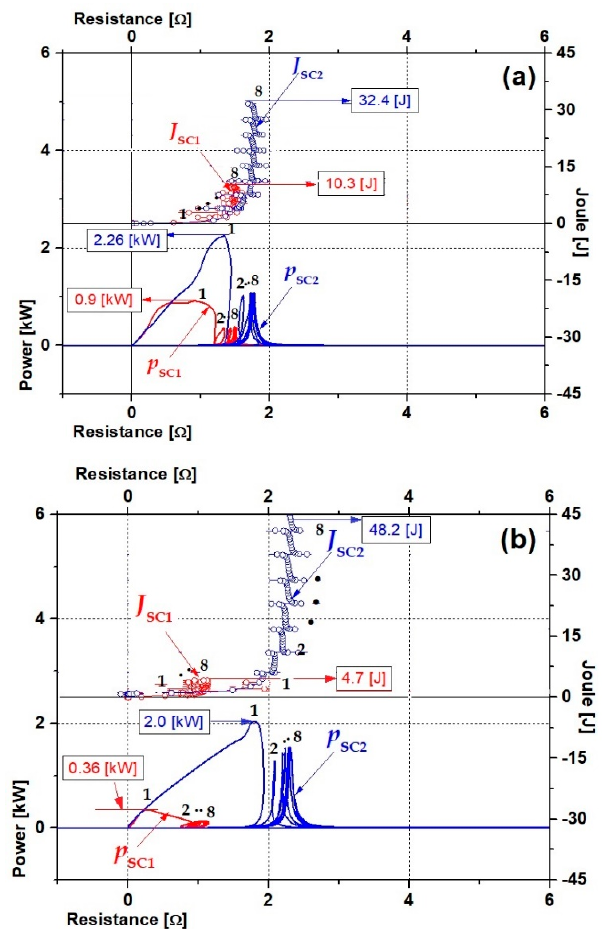
Figure 7. Instantaneous power and joule energy curves for resistance increase of two superconducting elements during the fault cycle: ( a ) the reverse winding direction ( b ) the same winding